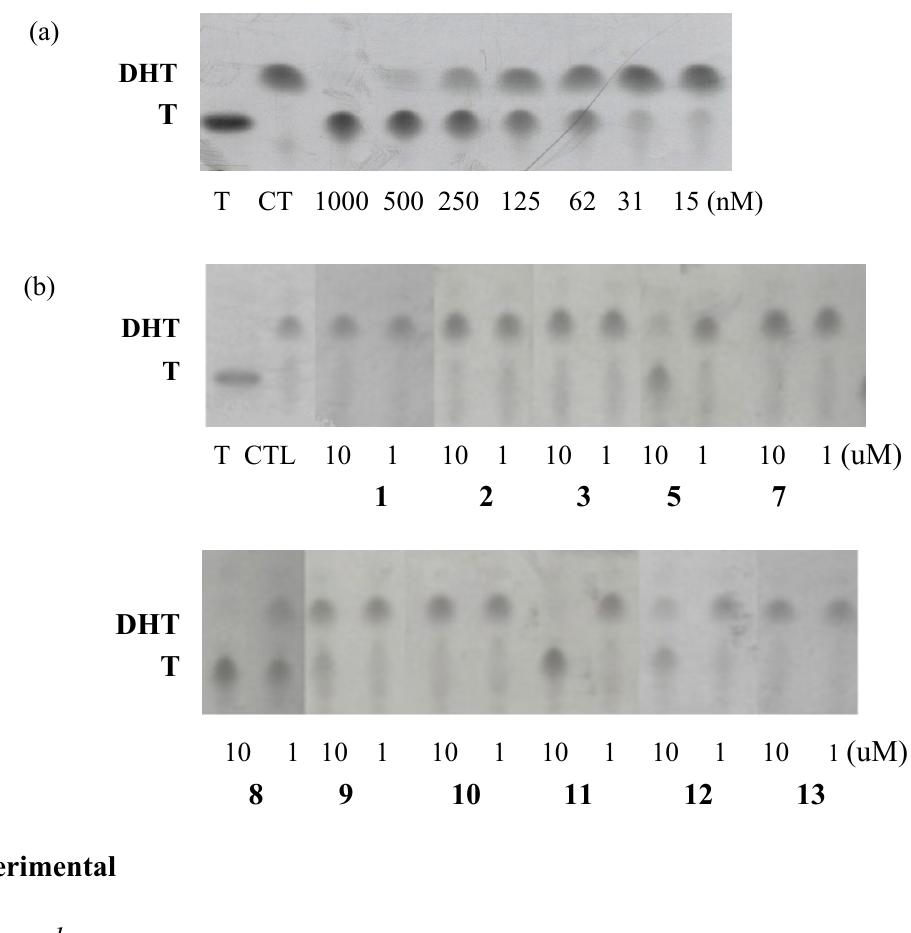
Figure 3. Data of type II 5 α -reductase inhibitory activity of finasteride (a) and synthetic compounds (b). Ten micrograms of stable cell extracts was incubated with 1 μ Ci [ 3 H]testosterone and synthetic compounds (1 μ M and 10 μ M) for 1 hr. T, testosterone; DHT, 5 α